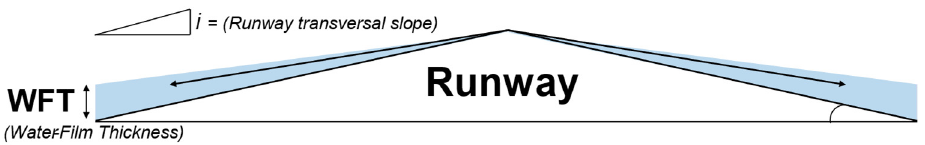
Figure 1. Raindrops outflow from an even runway.